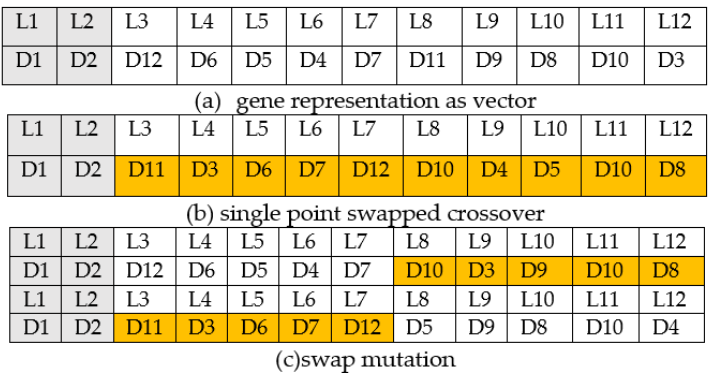
Figure 3. Crossover and Mutations.